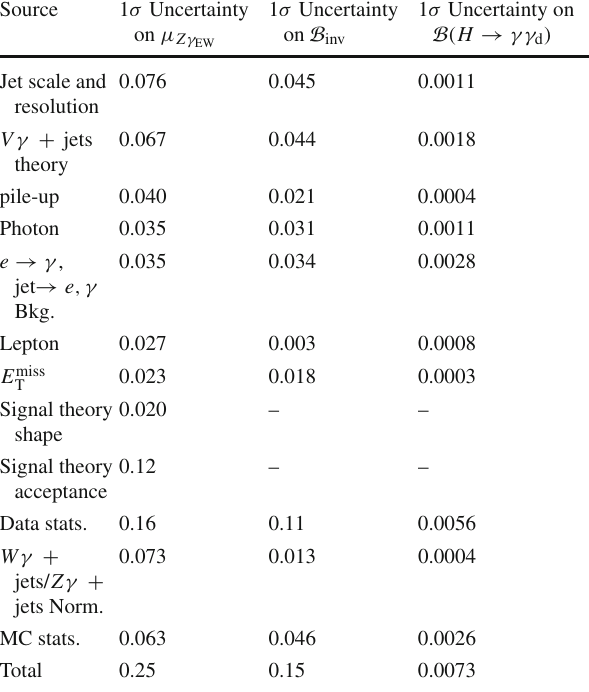
Table 7 The contributions from different groups of systematic uncer- tainties to the ± 1 σ uncertainty bands of the μ Z γ best-fit value and on EW B B ( H → γγ ) 95% CL limits. The evaluation is performed by inv and d fixing a given group of systematic uncertainties to their best-fit values and subtracting the new variance ( σ 2 ) of the best-fit value or the limit fromthenominalvarianceincludingallsystematicuncertainties.Dueto residual correlations between categories, the sum in quadrature of the systematic uncertainties can differ from the actual value. The uncer- tainty due to the finite number of data events (‘Data stats.’) is obtained by fixing all systematic uncertainties to their best-fit values. The sum of all systematic uncertainties is estimated by subtracting the statistical variance component from the total variance. The experimental uncer- tainties and the uncertainty related to the size of MC simulated samples (‘MC stats.’) are treated as separate categories. The V γ + jets theory entry includes the theoretical uncertainties in strong Z γ + jets, EW W γ + jets and strong W γ + jets production for μ Z γ ; however, for EW B B ( H → γγ ) , it also includes those from EW Z γ + jets. inv and d For the last two columns the impact of systematic uncertainties is com- puted from a fit to data with B inv = 0 or B ( H → γγ d ) = 0 for